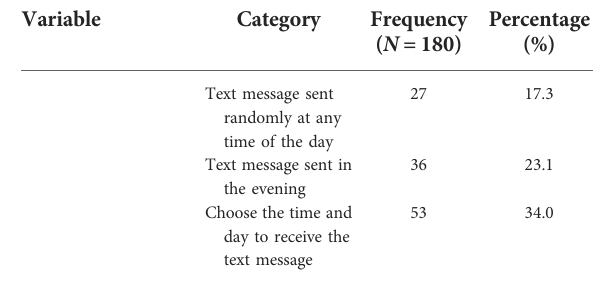
TABLE 4 Acceptability of digital technology for substance use